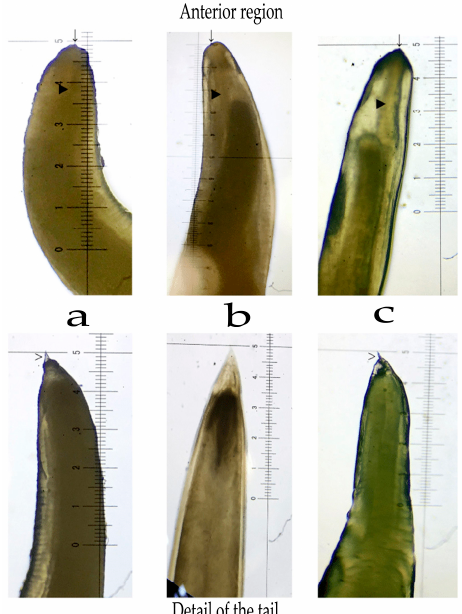
Figure2. Morphologicalstructuresusedforidentificationareobserved. ( a ) Anisakis spp.;( b ) Contracaecum spp.; and ( c ) Psedoterranova spp.